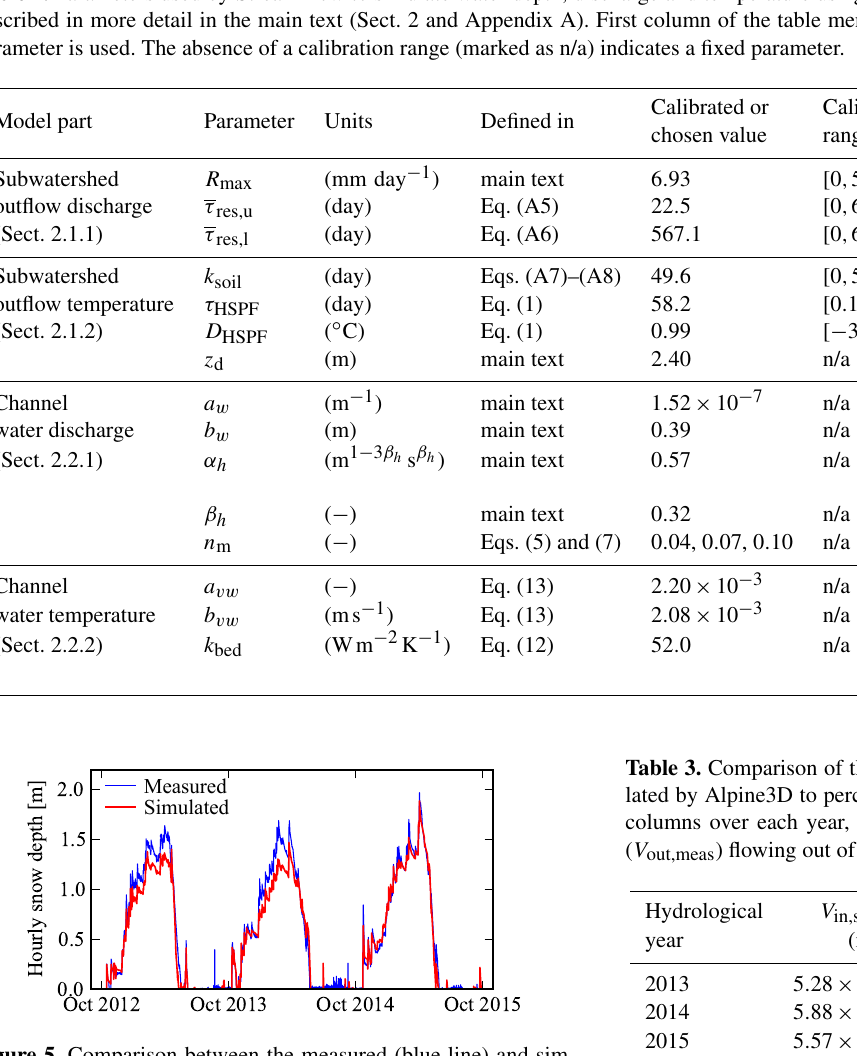
Figure 5. Comparison between the measured (blue line) and sim- ulated (red line) time evolution of snow depth at the Stillberg me- teorological station. The simulated curve corresponds to the mean snow depth as computed by Alpine3D over the 100 × 100m grid cell containing the Stillberg station.